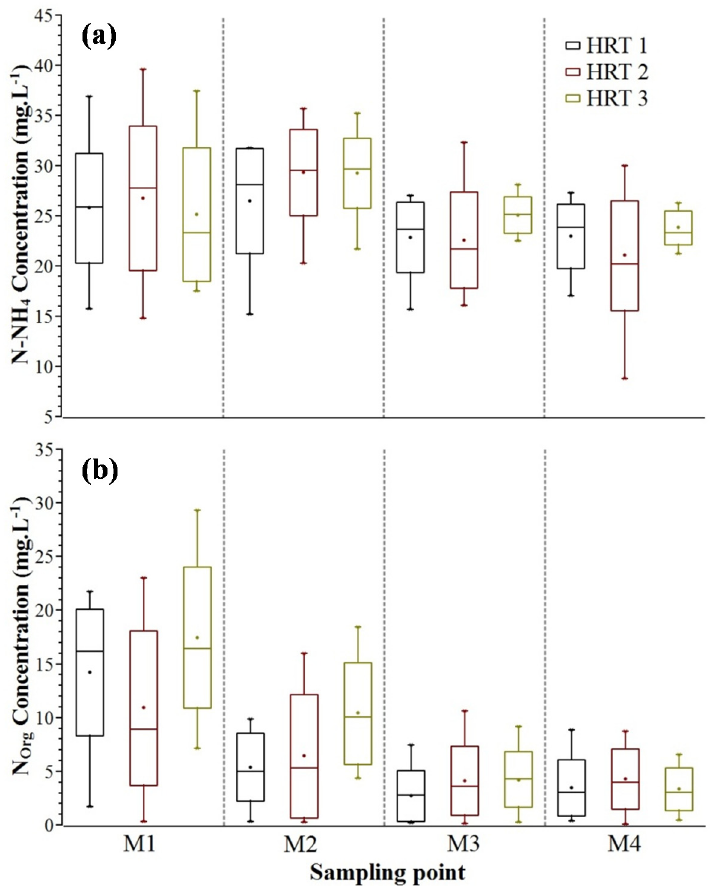
Figure 4. Plot of N-NH 4 (mg·L − 1 ) ( a ) and N Org (mg·L − 1 ) ( b ), with maximum and minimum values and standard